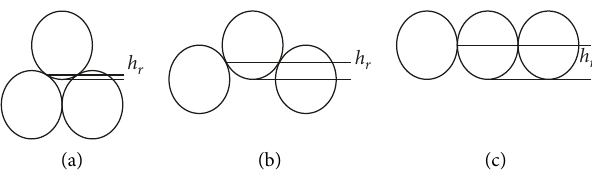
Figure 4: Schematic diagram of proppant arrangement during gas